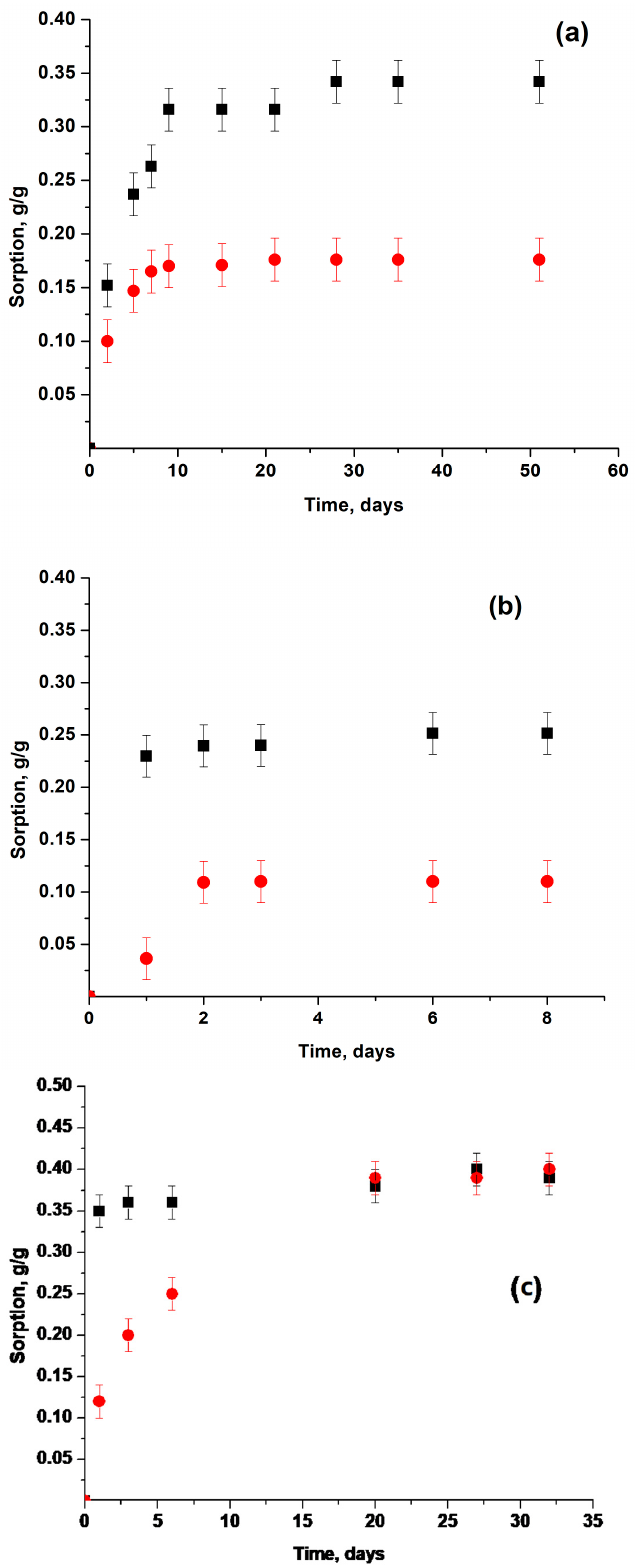
Figure 4. Sorption of acetonitrile ( a ), pyridine ( b ) and water ( c ) by HGO (9:3) membranes and powders. IM experiment, T = 298 K. Equilibrium sorptions correspond to the time independent parts of the curves. Black squares—powder; red circles—membrane.